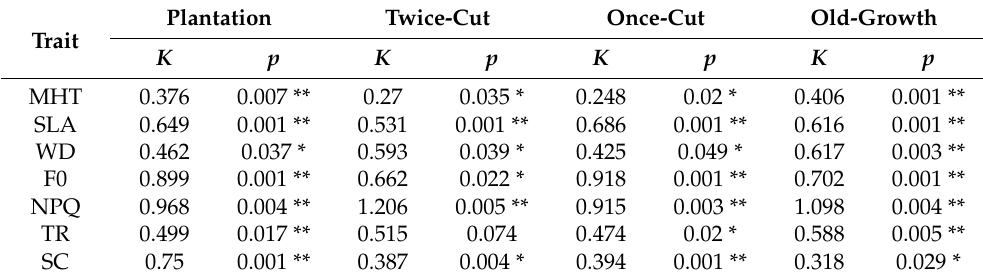
Table 2. Phylogenetic signal as measured by Blomberg’s K of functional traits in four disturbance regimes. MTH = maximum tree height (m); SLA = specific leaf area (cm 2 · g − 1 ); WD = wood density (g · cm − 3 ); F0 = minimal fluorescence; NPQ = non-photochemical quenching; TR = transpiration rate (mol · m − 2 · s − 1 ); SC = stomatal conductance (mmol · m − 2 · s − 1 ). “*” and “**” represent p < 0.05 and p < 0.01,